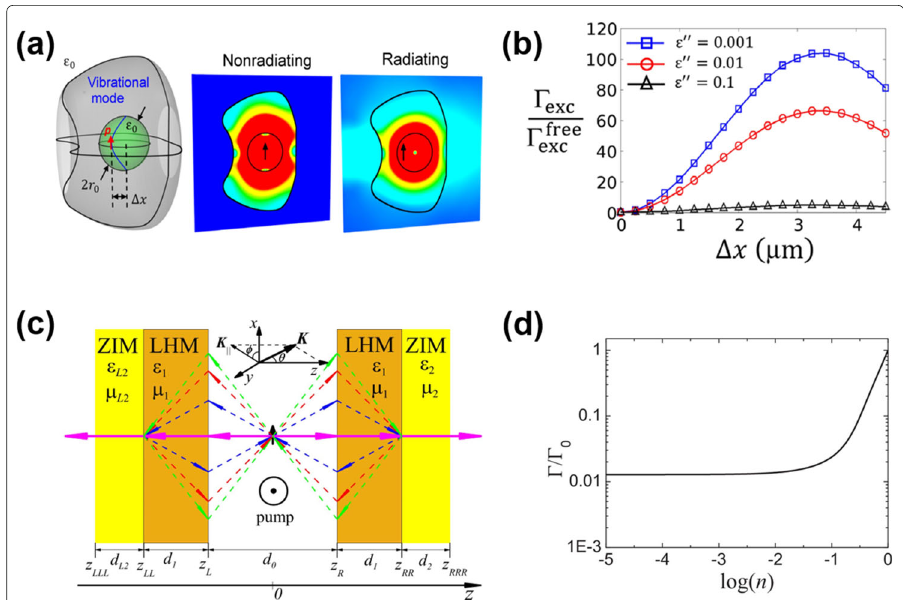
Fig. 10 a Sketch of air cavity embedded in the open ENZ materials with nonradiating and radiating modes [354]. b Purcell factors for different amounts of loss ( ε (cid:8)(cid:8) ) in the ENZ medium in structure ( a ) [354]. c Sketch of optical cavity made of zero-index metamaterial [337]. d Purcell factor of directional single photon source in structure ( c )